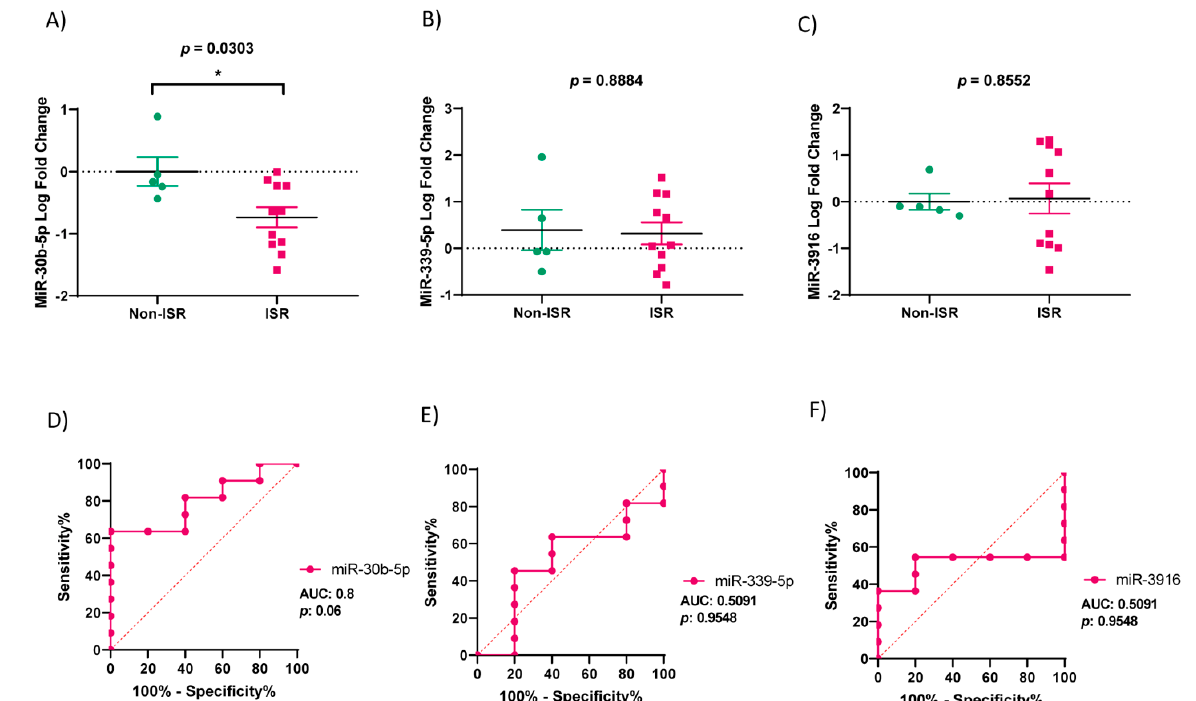
Figure 5. Validation of miRNA expression and ROC analysis in the non-ISR (green) and ISR (rose) patients’ groups. ( A – C ) Graphs showing levels of miR-30b-5p, miR-339-5p and miR-3916 in non-ISR and ISR, expressed in log of fold change. Values are means ± S.E.M (n = 16). “*” indicates significance at p < 0.05. ( D – F ) Graphs illustrate area under the curve (AUC) analysis of ROC indicating sensitivity and specificity of miR-30b-5p, miR-339-5p and miR-3916. Green and rose colors indicate Non-ISR and ISR patients respectively.